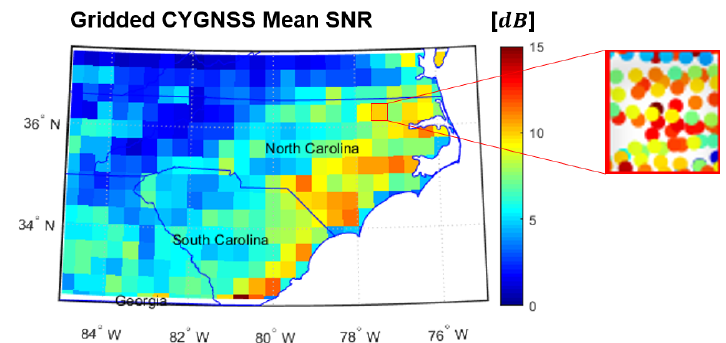
Figure 1. Multiple CYGNSS observations (uncalibrated DDM SNR) that are averaged into the SMAP grids. Data are from 14–18 September 2018 over North Carolina, USA (The landfall of the Hurricane Florence was on 14 September